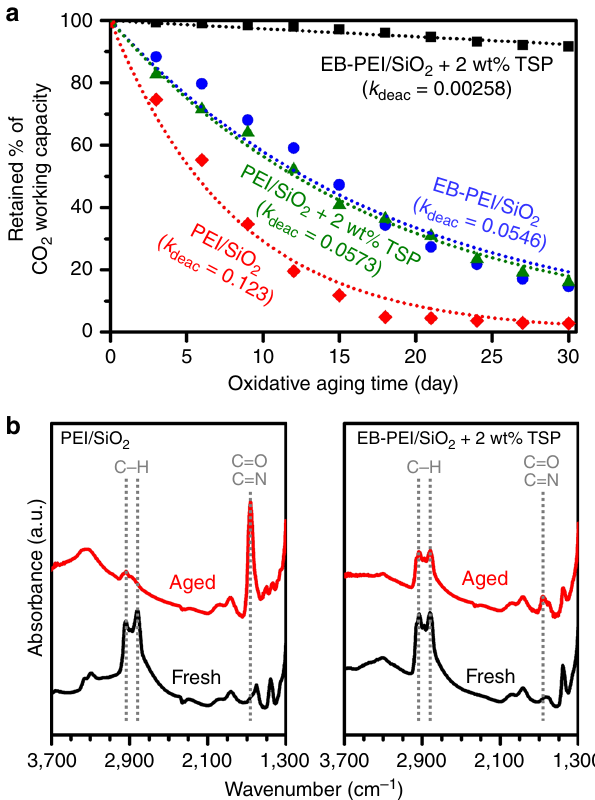
Fig. 5 Long-term oxidative stabilities of adsorbents. a Retained CO 2 working capacity (%) of PEI/SiO 2 and EB-PEI/SiO 2 prepared with and without 2 wt% trisodiumphosphate (TSP) after aging under 3% O 2 , 15% CO 2 , 10% H 2 O in N 2 balance at 110 °C. The trend lines are obtained by fi tting with the fi rst-order deactivation model. b FT-IR spectra of PEI/SiO without TSP and EB-PEI/SiO 2 with 2 wt% TSP, before and after